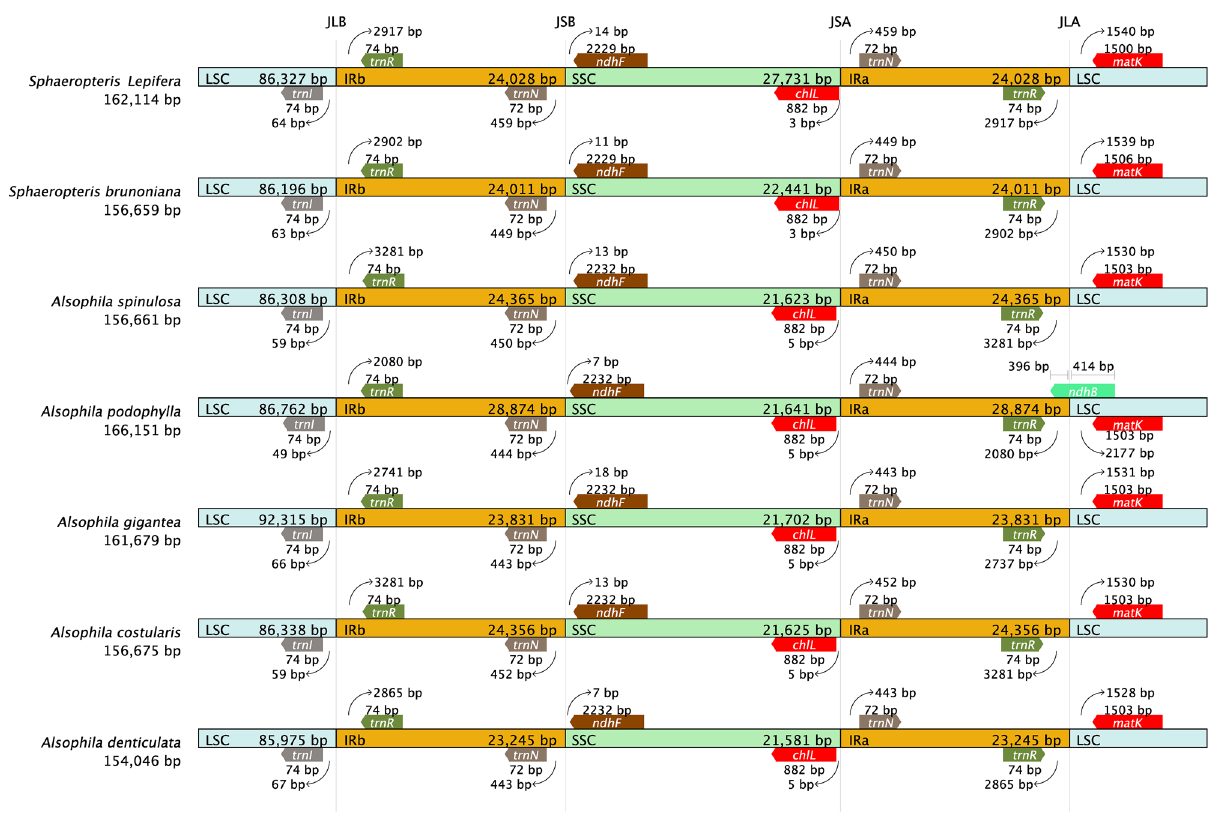
Figure 5. IR and SC boundary